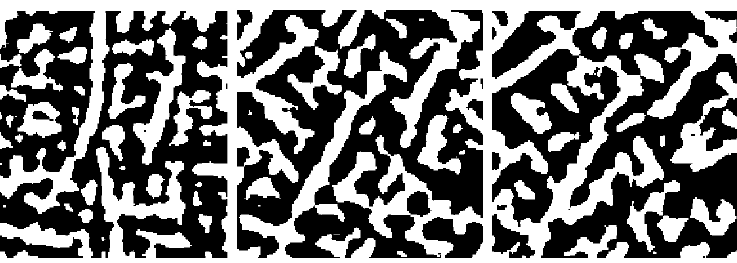
Figure 14. Palm print OLOF features for ,